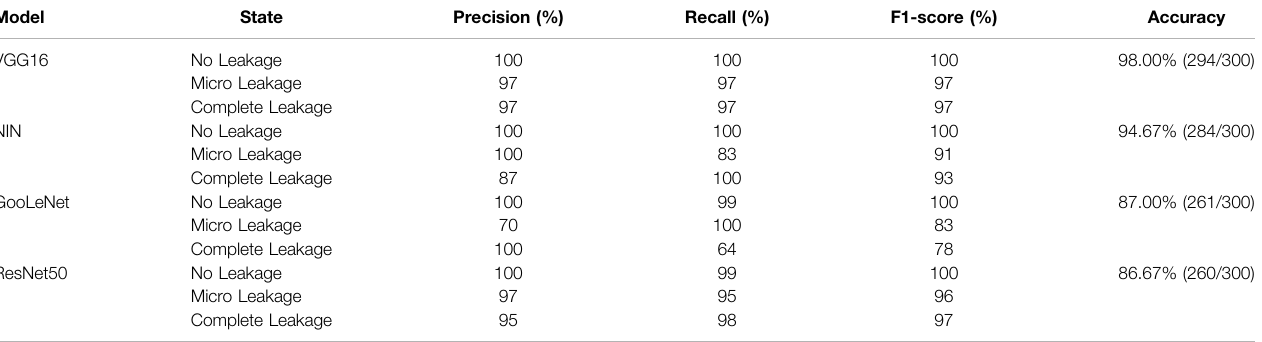
TABLE 1 | Comparison table of the comprehensive evaluation of experimental results of different CNN models.